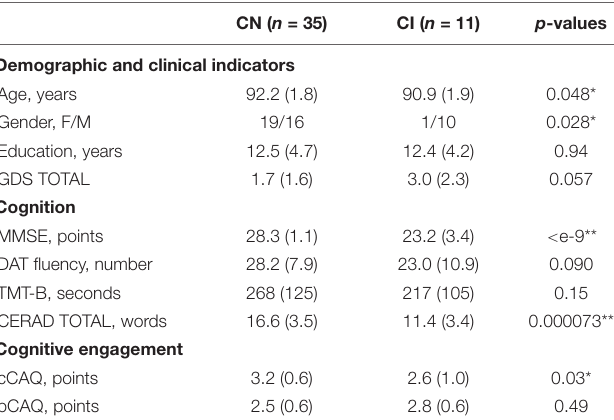
TABLE 1 | Demographic and cognitive